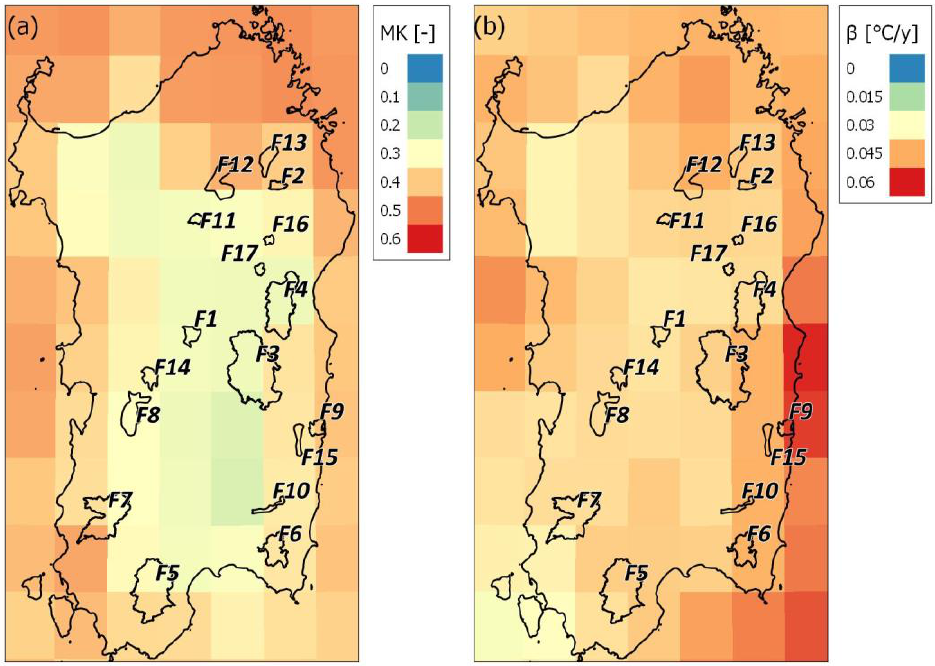
Figure 7. Spatial distribution of the Mann‒Kendall τ ( a ) and Theil‒Sen slope ( b ) in annual temperature, Ty , derived from ERA5 during the 1990 – 2020 period. The thin black outlines indicate the 17 forests analyzed.